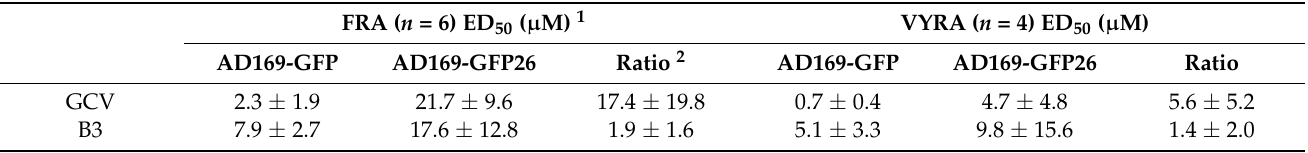
Table 1. Summary of FRA and VYA for AD169-GFP and AD169-GFP26.